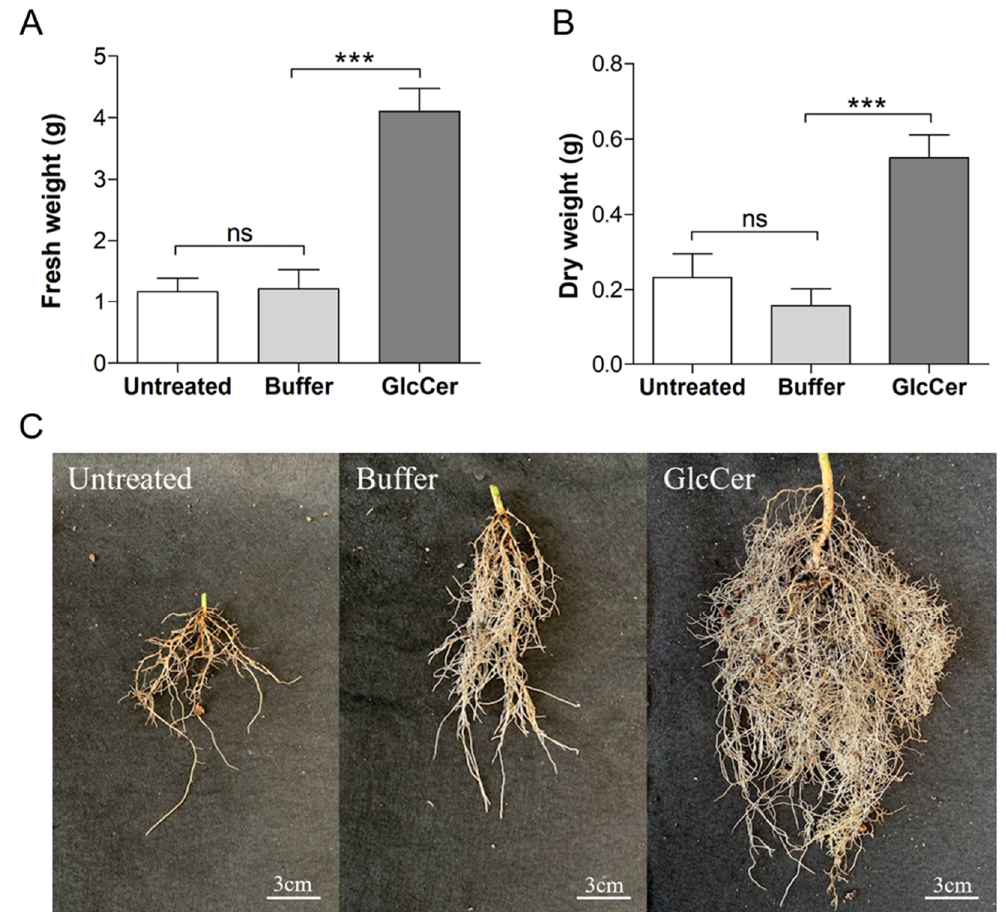
Figure 9. Effects of GlcCer on root weight. Untreated plants were used as negative control. ( A ) Root fresh weight. ( B ) Root dry weight. ( C ) Appearance of fresh roots. Untreated: plants with no treatment; Buffer: plants sprayed with potassium phosphate buffer 0.01 M; and GlcCer: plants sprayed with 100 µg/mL GlcCer. The size measurement of five plants for each treatment was made 40 days after spraying. ns = not significant. *** p < 0.001.